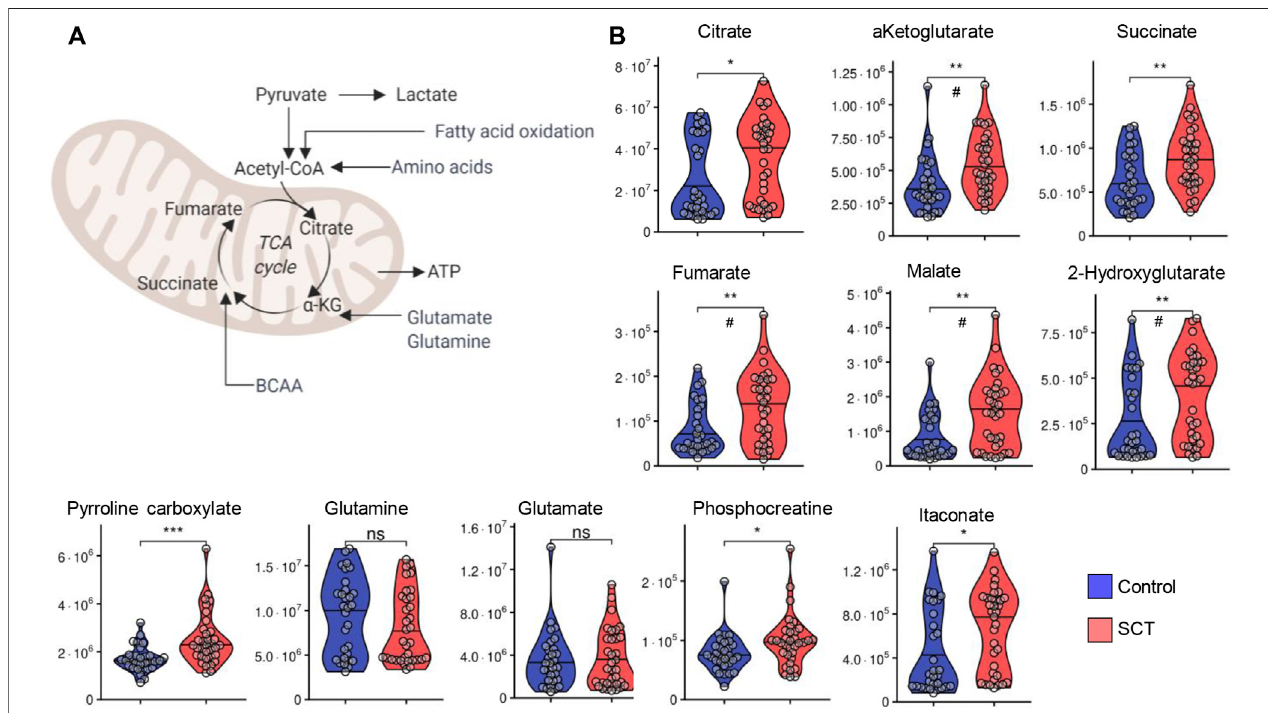
FIGURE 6 | Overview of carboxylic acid metabolism and glutaminolysis (A) and violin plot representation of metabolites in these pathways (B) as measured in plasma from control (blue) and sickle cell trait (red) subjects. Asterisks indicate signi fi cance (* p < 0.05; ** p < 0.01; *** p < 0.001 Wilcoxon/Mann-Whitney U -test). FDR- corrected p -values are provided for all analytes in Supplementary Table S1 and indicated with # using the same signi fi cance ranges as per the asterisks in p -values above.